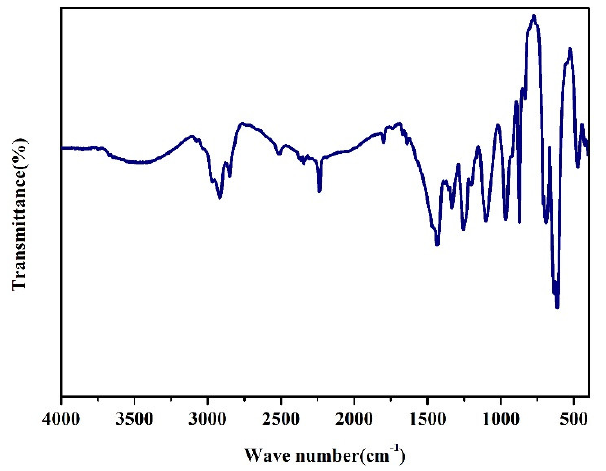
Figure 2. FTIR spectrum of